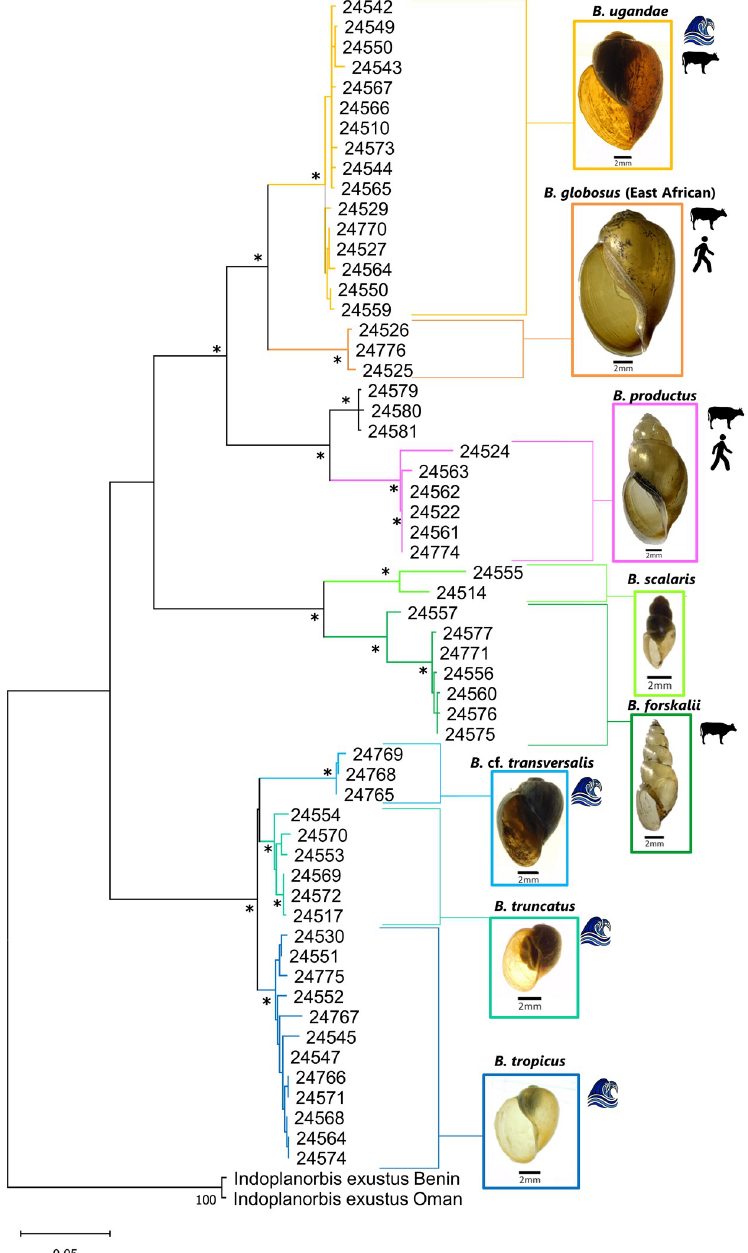
Fig 2. Phylogenetic relationships of bulinids based on concatenated cox1 + 16S sequences. Phylogenetic relationships of bulinids from this study and from GenBank based on 1163 bp of combined cox1 and 16S sequences inferred from ML analysis under the GTR+G+I model. Bootstrap values above 95 are indicated by an asterisk. Sequences generated during this study are listed by MSB:Host number. Additional information for specimens can be found in Table 1. Specimens recovered within the LVB by this study are color coded by species. B . africanus group species are in warm colors, B . forskalii group species in greens, and B . truncatus/tropicus group species in blues. Wave icons indicates species found within Lake Victoria. Cow icons indicate species with naturally occurring S . bovis infections. Human icons indicate species with naturally occurring S . haematobium infections.